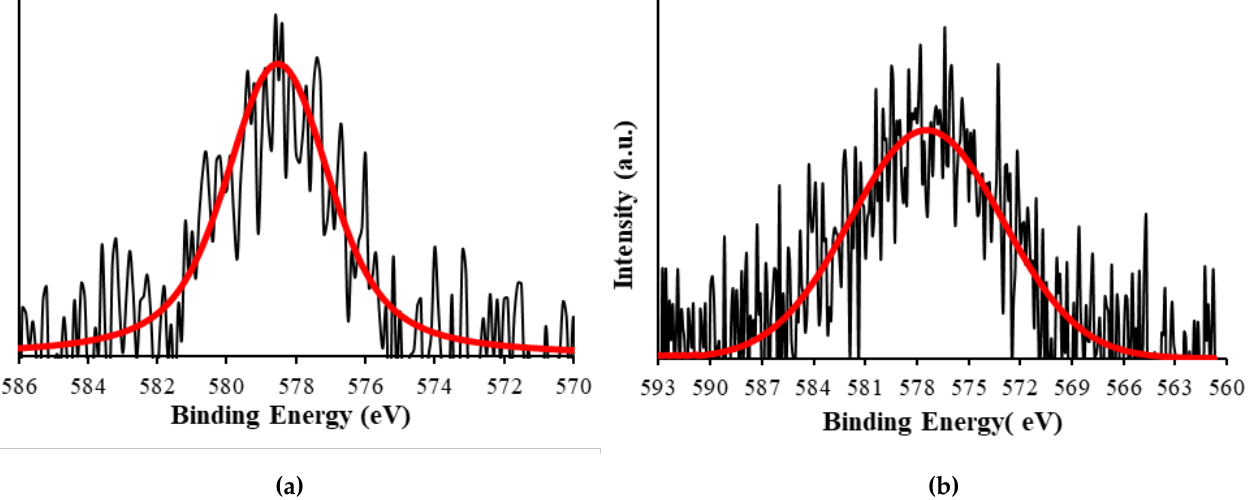
Figure 12. XPS spectra of Cr2p 3/2 for silica-based xerogel ( a ) before and ( b ) after treatment with DPC.